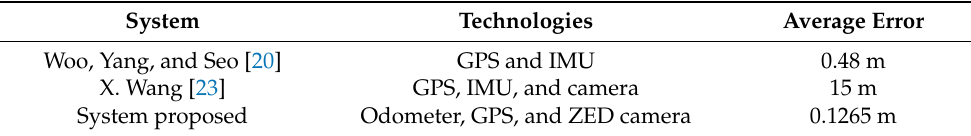
Table 5. Comparative of models to estimate the